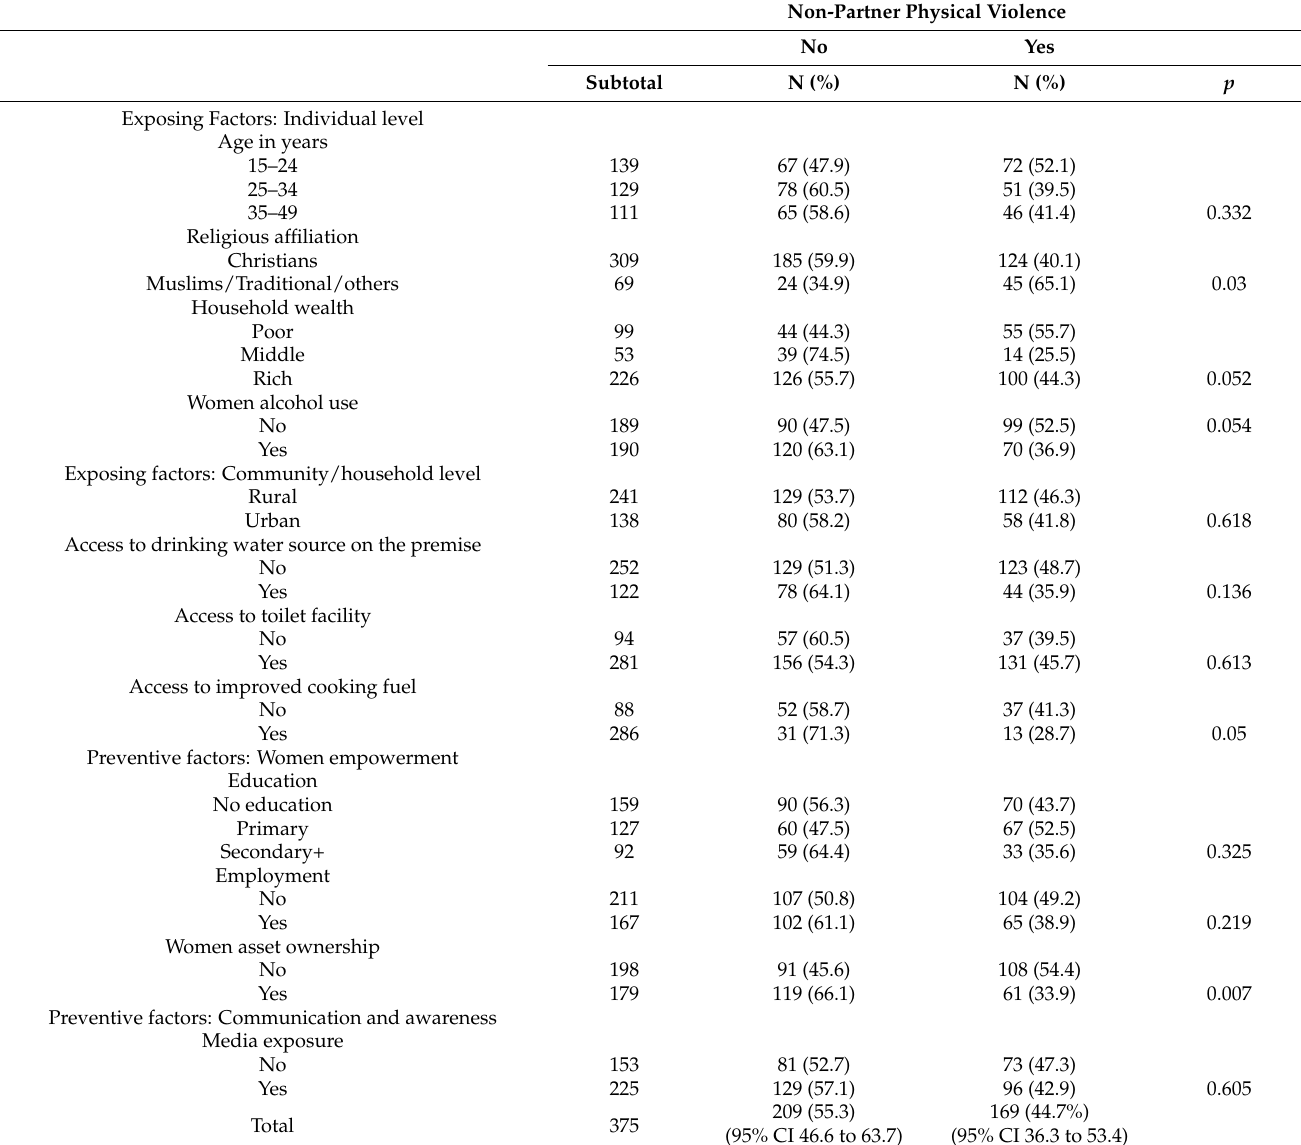
Table 2. Hypothesized exposing and protective factors in relation to non-partner physical violence among Ethiopian women. Non-Partner Physical